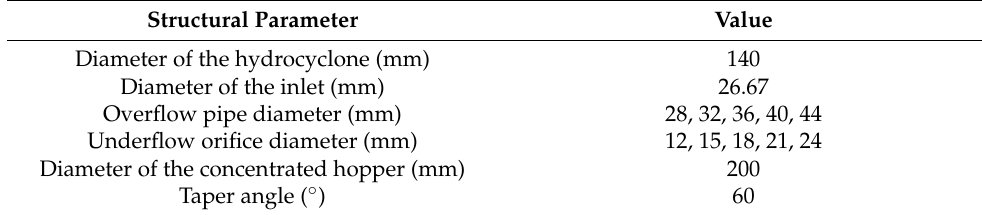
Table 1. Structure parameters of the hydrocyclone.